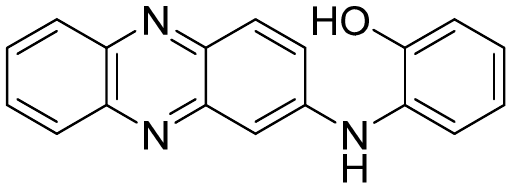
Figure 4. Structure of N -(2-hydroxyphenyl)-2-phenazinamine (NHP).